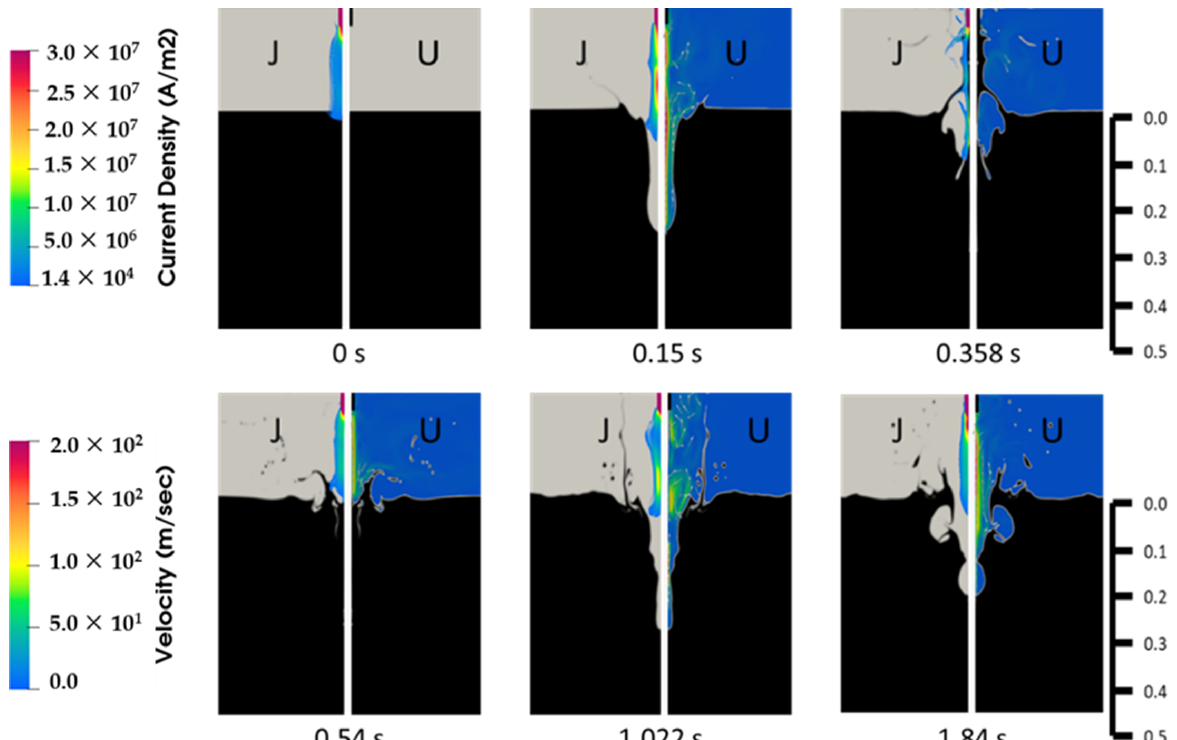
Figure 8. Liquid metal impingement by an arc jet for a 2.0 × 10 −1 m arc gap.